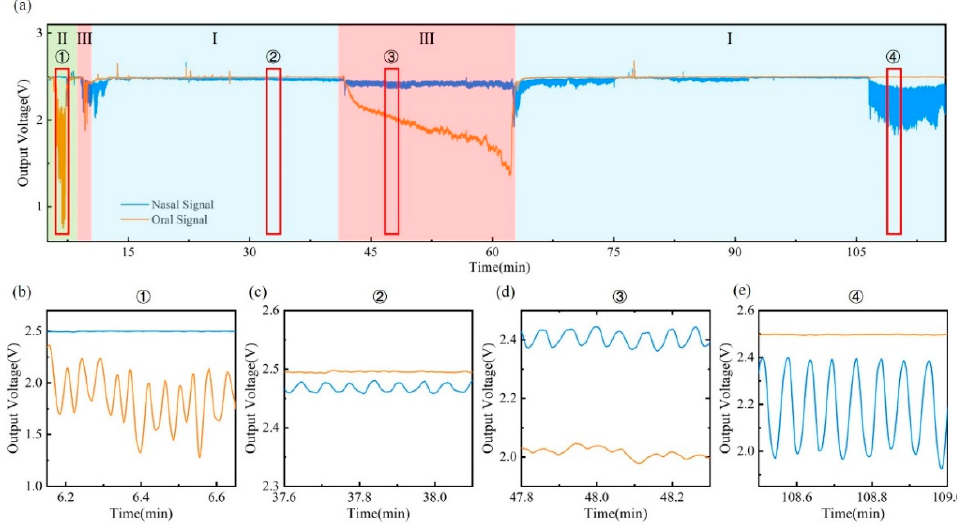
Figure 5. Sleep respiratory monitoring of healthy volunteer: ( a ) Breathing signals throughout the test (I: nasal breathing; II: oral breathing; III: oral–nasal co-breathing). ( b – e ) Detailed signals for dif- and stage ④ ), and oral–nasal co-breathing (stage ③ ).